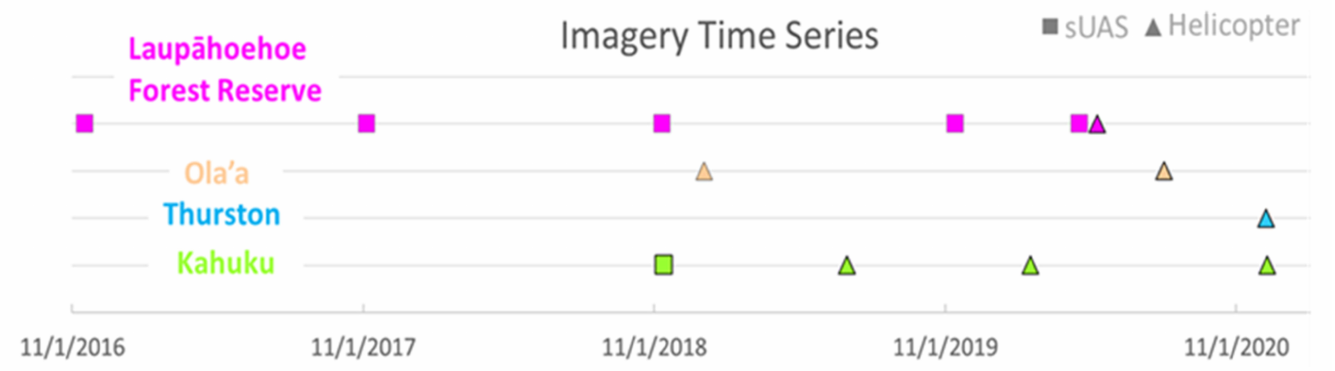
Figure 2. Timeline of sUAS and helicopter imagery included in this study for the four sites.